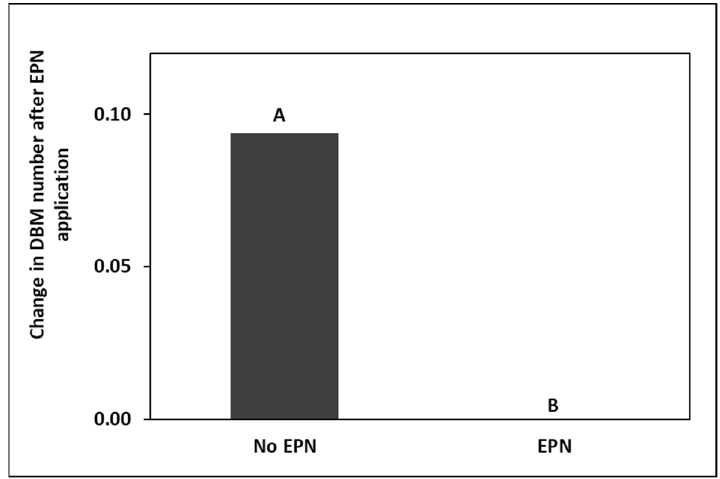
Figure 15. Effects of EPN on abundance of diamondback moth (DBM) in Kale Trial II. Means followed by the same letters in a graph are not different based on analysis of variance.